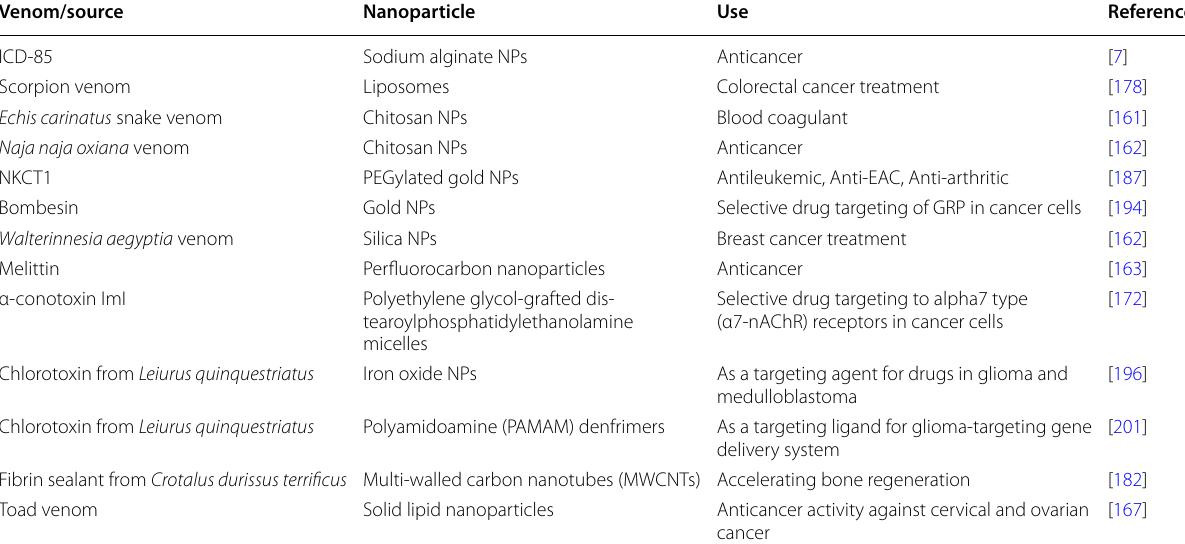
Table 3 Summary of nanoparticle-conjugated venom peptides